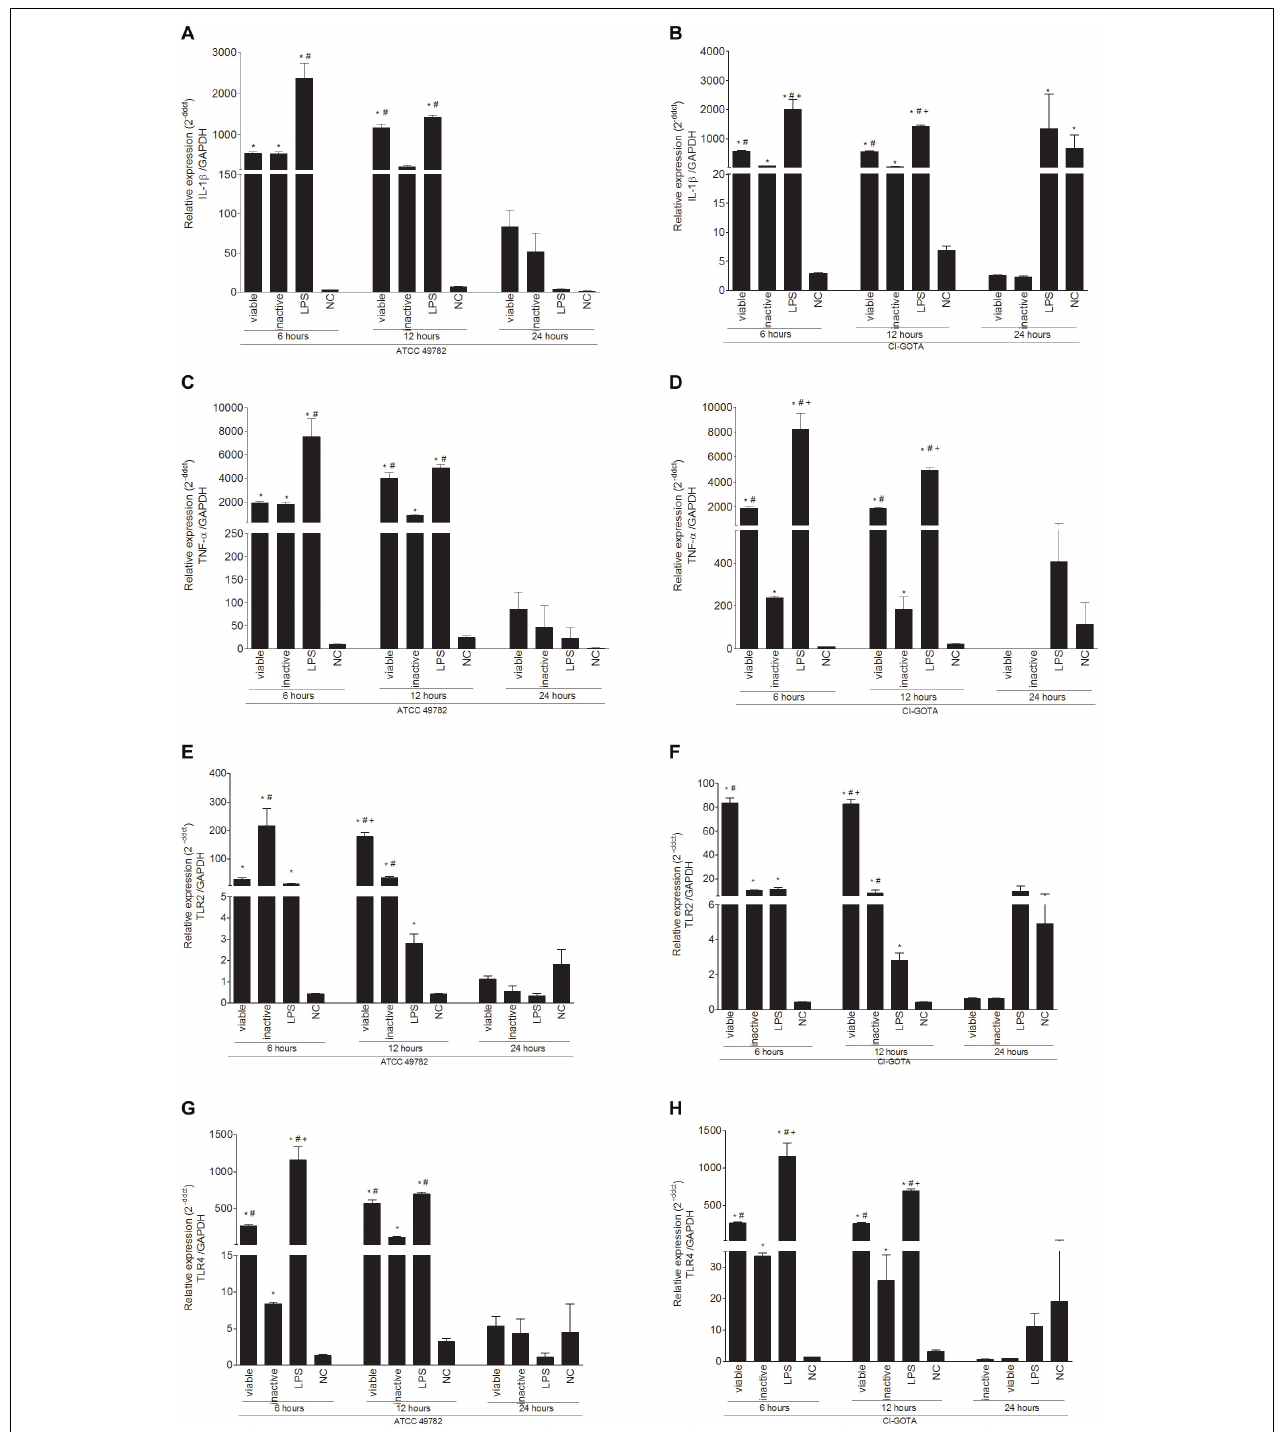
FIGURE 1 | Gene expression in bovine macrophages infected with viable and inactive U. diversum (ATCC 49782 – 10 6 Ureaplasma /mL and CI-GOTA – 10 5 Ureaplasma /mL) for 6, 12, and 24 h. (A) IL-1 β Expression induced by ATCC 49782. (B) IL-1 β expression induced by CI-GOTA. (C) TNF- α expression induced by ATCC 49782. (D) TNF- α expression induced by CI-GOTA. (E) TLR2 expression Induced by ATCC 49782. (F) TLR2 expression in macrophages inoculated with the CI-GOTA. (G) TLR4 expression induced by ATCC 49782. (H) TLR4 expression induced by CI-GOTA. Groups were compared using the Kruskal–Wallis non-parametric test followed by the Dunn post-test. PBS was used as negative control (CN) and 100 ng/mL of LPS was used as positive control. Statistical significance ( p < 0.05) is represented by the symbols ( ∗ difference with the NC group, # difference with the LPS group, + difference with the inactive group). Data are expressed as mean ± standard deviation ( n =